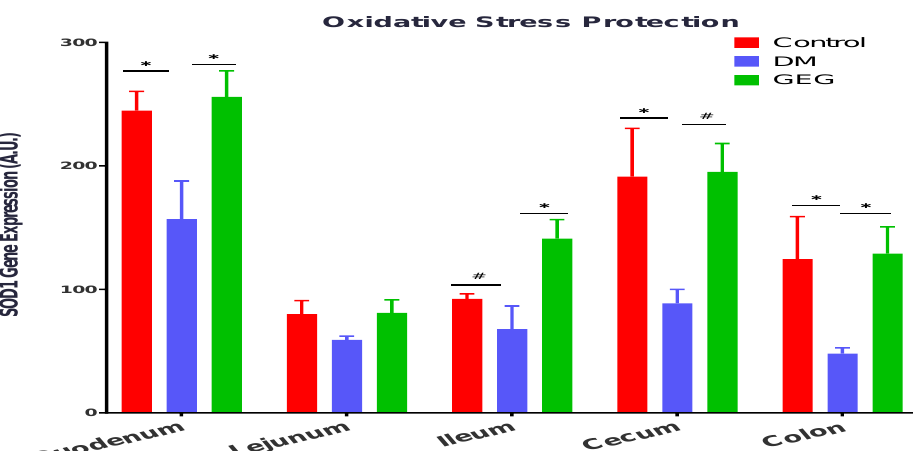
Figure 13. Effect of gingerol-enriched ginger (GEG) on mRNA gene expression of SOD1 in duodenum, jejunum, ileum, cecum, and colon of rats. n = 6–8 per group. Data is expressed as mean ± SEM. n = 6–8 per group. Data was analyzed by one-way ANOVA followed by a post hoc Tukey’s test. * p < 0.05. # 0.05 < p < 0.1.